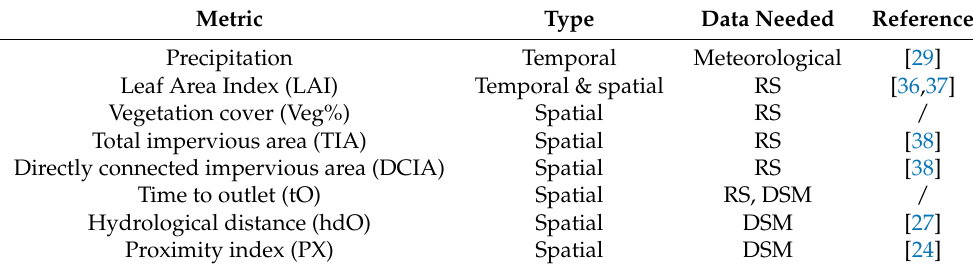
Table 1. The metrics. The type indicates if they are distributed in space or in time. The data needed refers to the input needed to create those metrics: remote sensing (RS) data, digital surface model (DSM) retrieved from LiDAR data or meteorological datasets. The reference helps to understand the origin of the metric definition or the dataset.